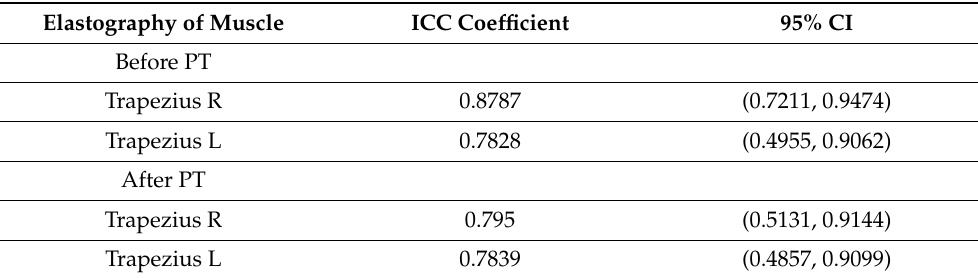
Table 3. Inter-observer reliability of elastography measurements in trapezius muscles before and after physical